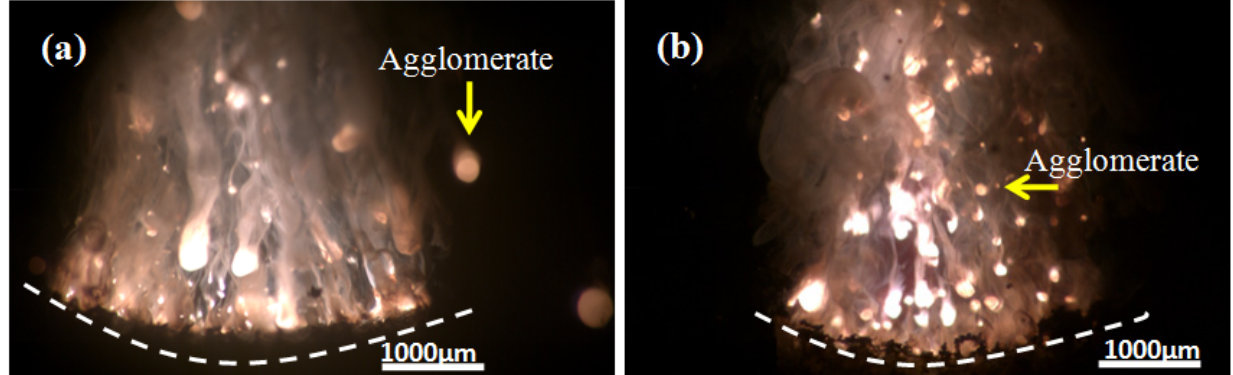
Figure 3. Combustion of propellant at 5 MPa pressure: ( a ) HA-1; ( b )HA-5.